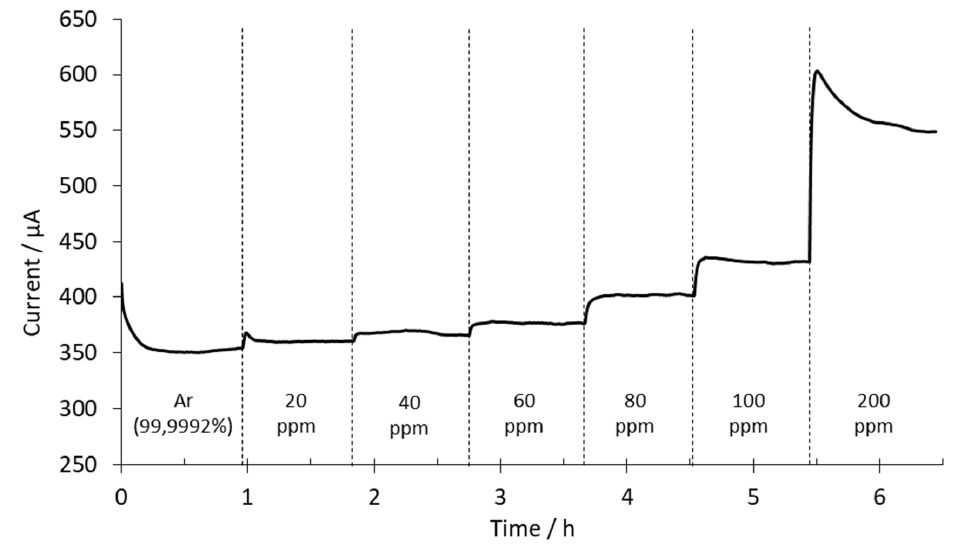
Figure 8. Chronoamperometry performed at 500 °C and 4 V with the BaCeZrY sensor.